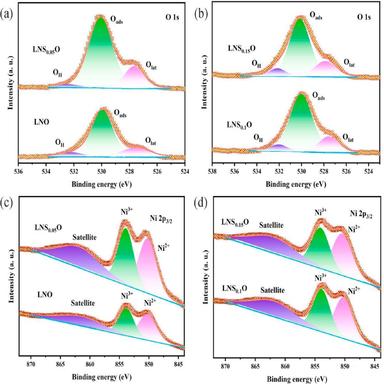
XPS spectra of La2Ni1-xScxO4+δ (x = 0, 0.05, 0.10 and 0.15) samples: O 1s (a–b),Ni 2p (c–d).